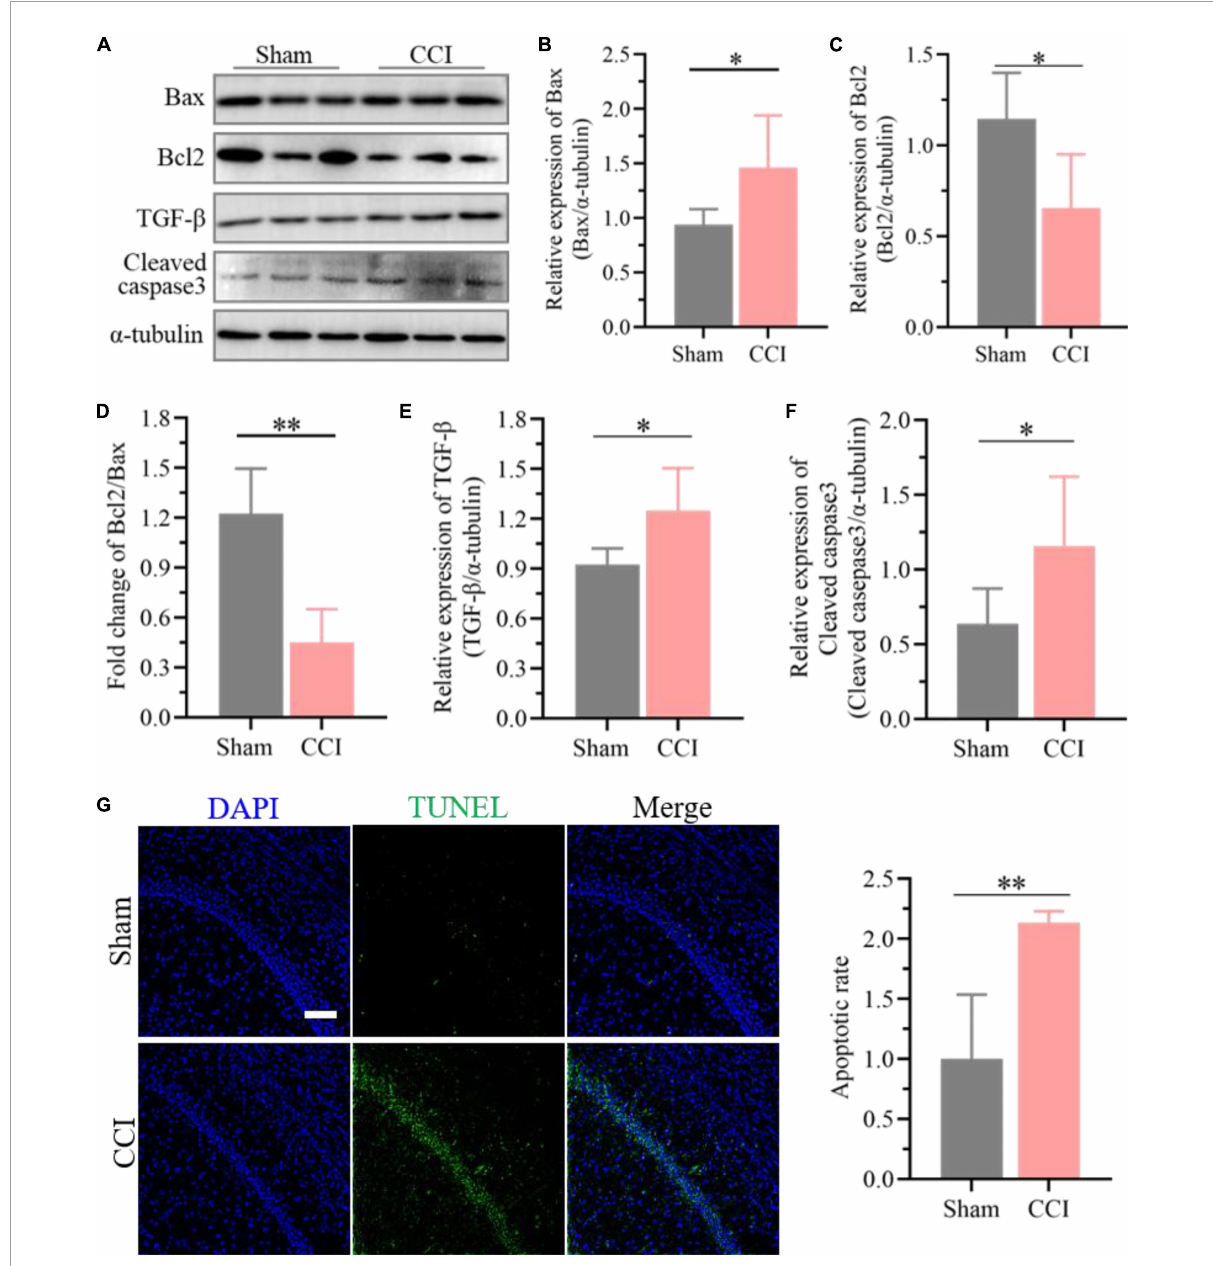
FIGURE6 Enhanced neuronal apoptosis after CCI plays essential roles in cognitive deficits. (A) Representative images of western blotting showing the expression levels of Bcl-2, Bax, TGF- β and cleaved caspase-3 in the hippocampus of CCI and sham rats. (B,C) Quantitative analysis of (B) Bax and (C) Bcl-2 expression after CCI using ImageJ software. (D) The proportion of Bcl2 and Bax was calculated. (E,F) Quantitative analysis of (E) TGF- β and (F) cleaved caspase-3 expression after CCI using ImageJ software. Data of (B–F) are presented as the mean ± SD ( n = 6), and the statistical analysis was conducted via unpaired Student’s t -test. ∗ P < 0.05, ∗∗ P < 0.01. (G) Representative images for TUNEL detection in the hippocampal CA1 region after CCI, and the percentage of apoptotic ratio was quantified. Error bars represent the mean ± SD ( n = 5), and